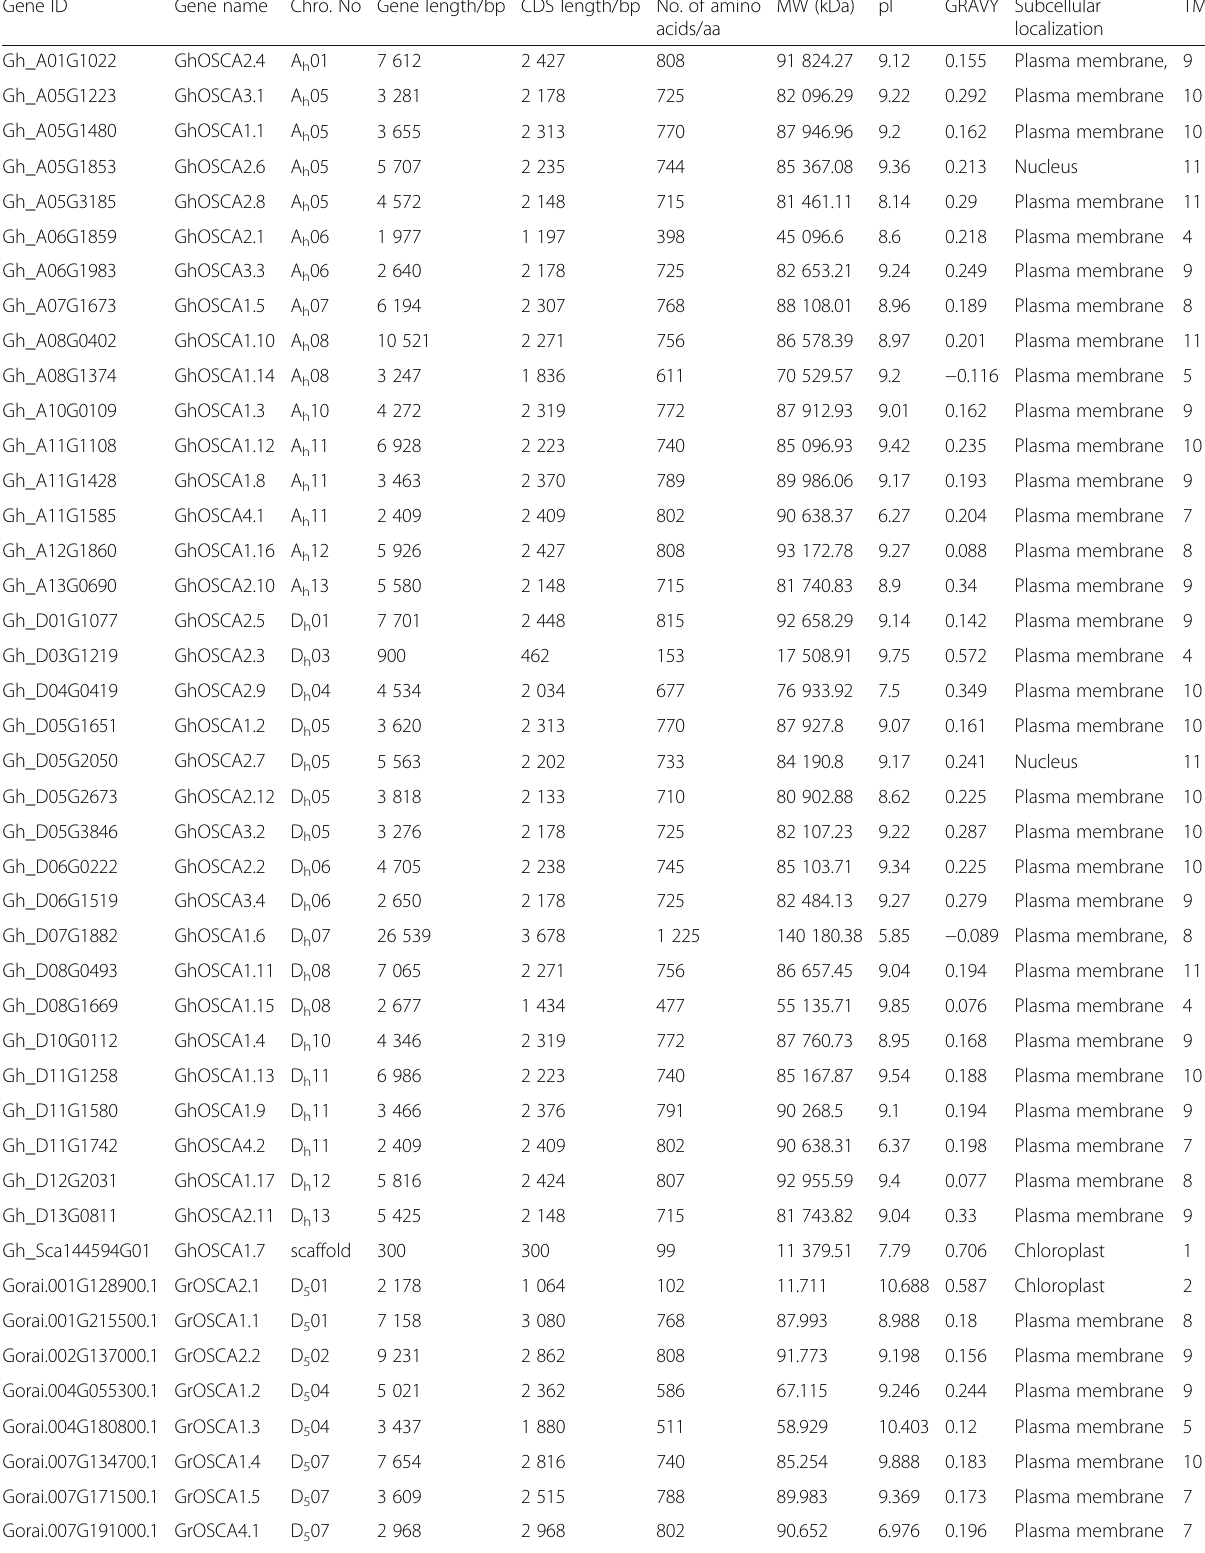
Table 2 Physicochemical Properties of OSCA Gene Gene